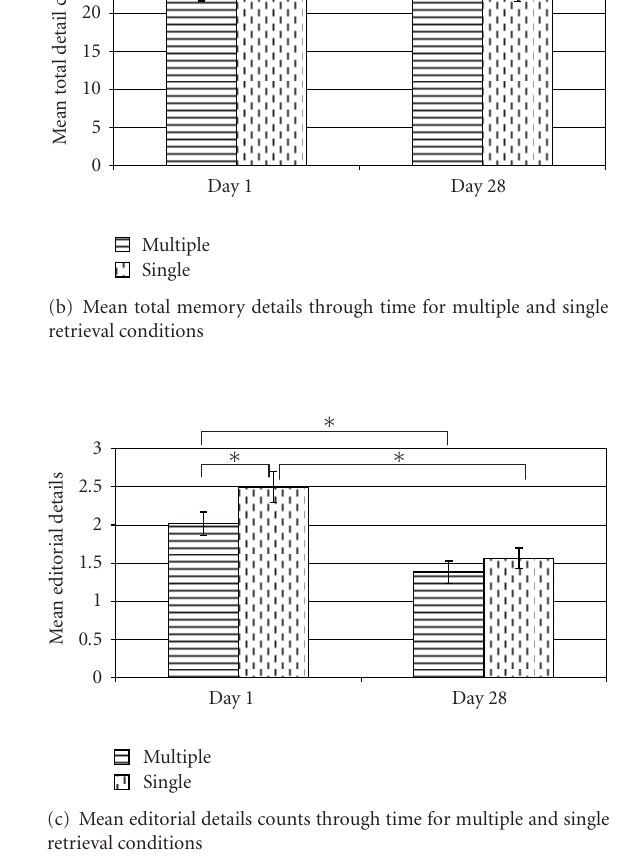
Figure 3: Mean detail measures across retrieval session for multiple and single retrieval conditions. Mean word count (a) and mean to- tal memory detail count (b) significantly increased between Day 1 and Day 28 for the multiple retrieval condition but not for the sin- gle retrieval condition. Mean editorial detail count (c) was signifi- cantly di ff erent between the multiple and single retrieval conditions on Day 1 and between Day 1 and Day 28 for both the multiple and single